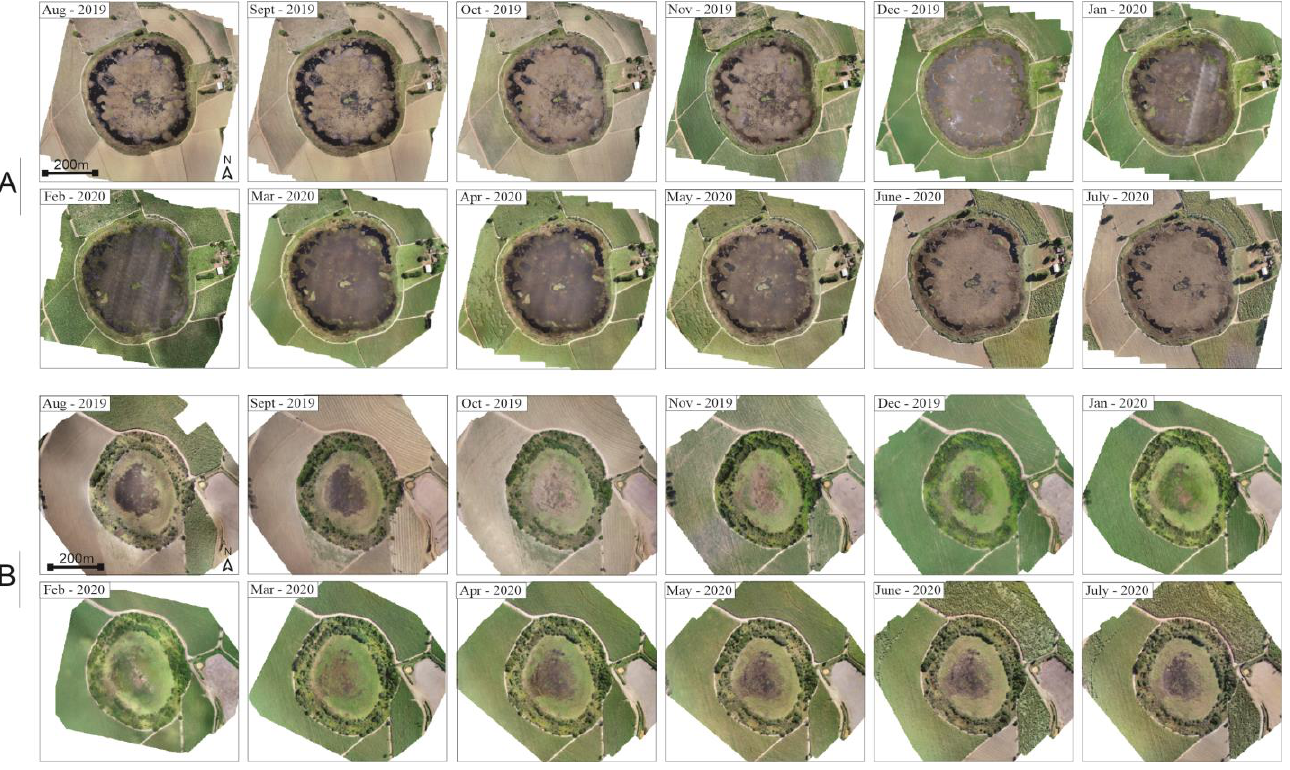
Figure 4. One-year (August 2019–July 2020) systematic acquisition of Wetland A ( A ) and Wetland B ( B ) UAV-orthomosaics.